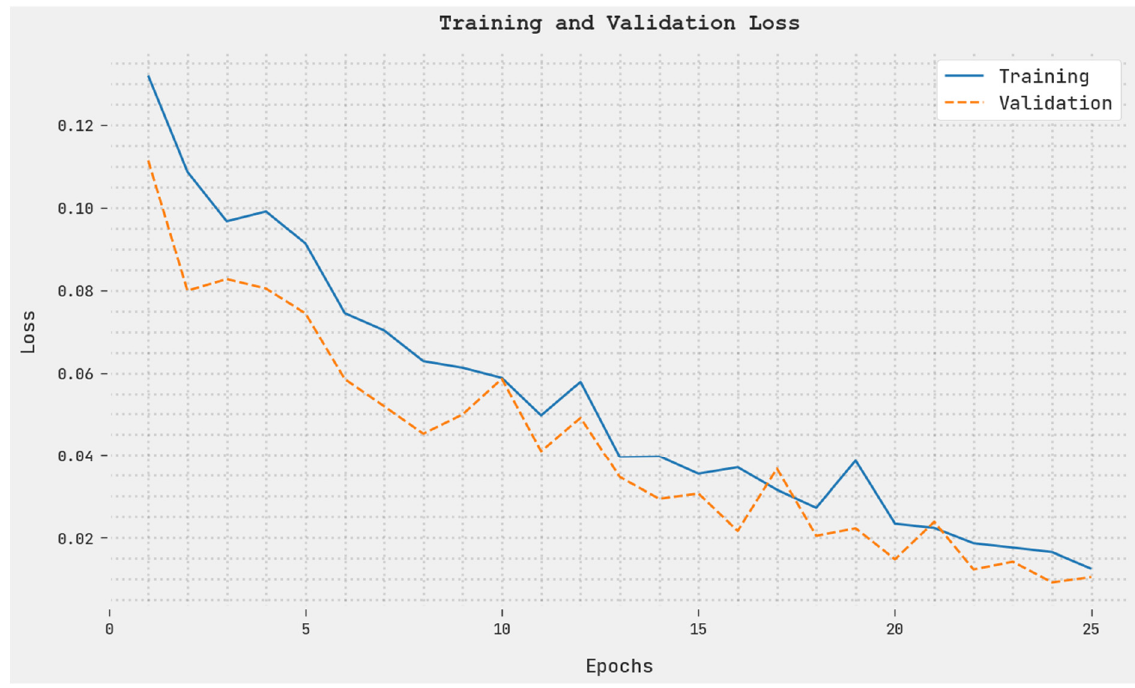
Figure 7. TRL and VLL analysis of DWOML-RWD approach.